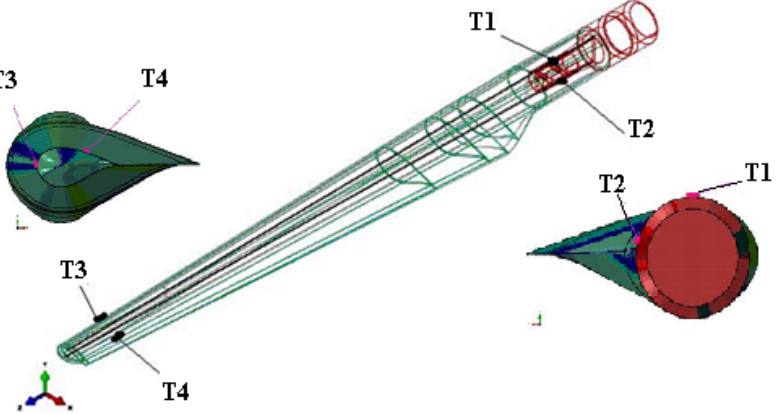
Figure 11. Overview and details of the location of the transducers.